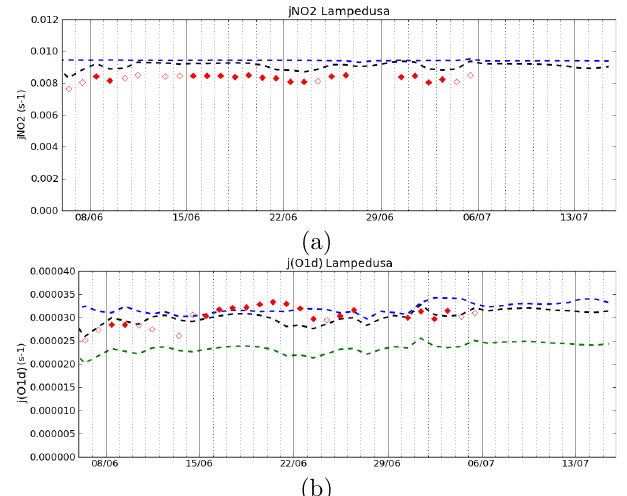
Figure 13. (a) Daily maximal values of modelled J( NO 2 ) in s − 1 for the REF simulation (black dashed line) and the NA simulation (blue dashed line), and measured values of the daily maxima (red diamonds). The days when significant effect of clouds was visible on the spectrometer measurements are signalled on the plot by an empty red diamond. (b) Same as (a) for J( O 1 D ) . The green dashed line represents the J( O 1 D ) values in the O3+